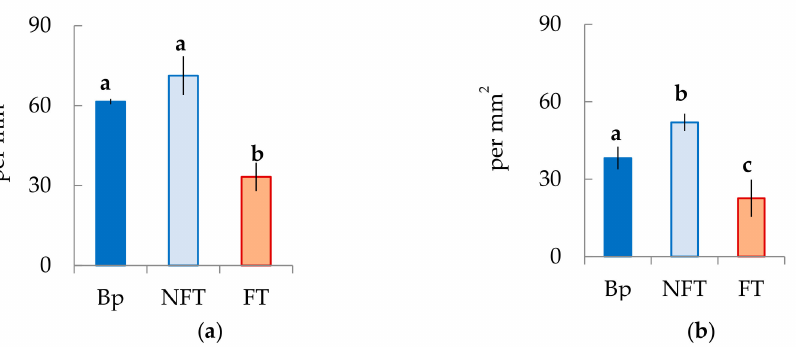
Figure 5. The vessel density is defined as the number of individual vessels per mm 2 in the mature xylem of B. pendula var. pendula (Bp), non-figured (NFT), and figured (FT) B. pendula var. carelica trees. Samples were collected on 25 June 2019 ( a ) and 26 June 2020 ( b ). Different letters indicate significant differences at p -value < 0.05. Bars are means of n experimental runs ± SD according to Mann–Whitney U-test. n =